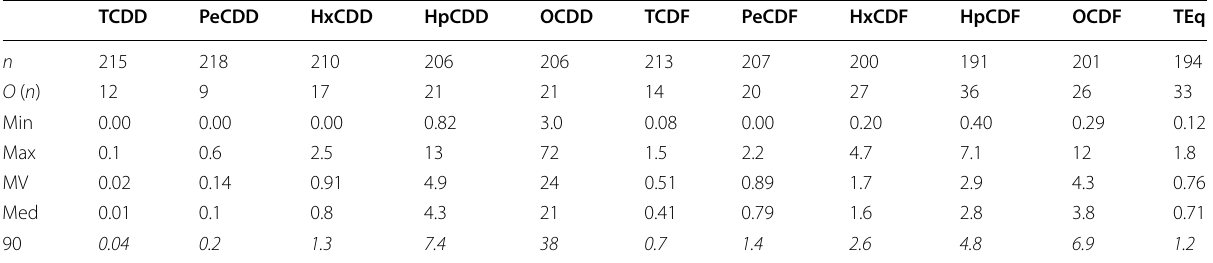
Table 5 Descriptive statistical results of PCDD/F-homologues [ng kg − 1 DM] in Bavarian grassland top soil layers